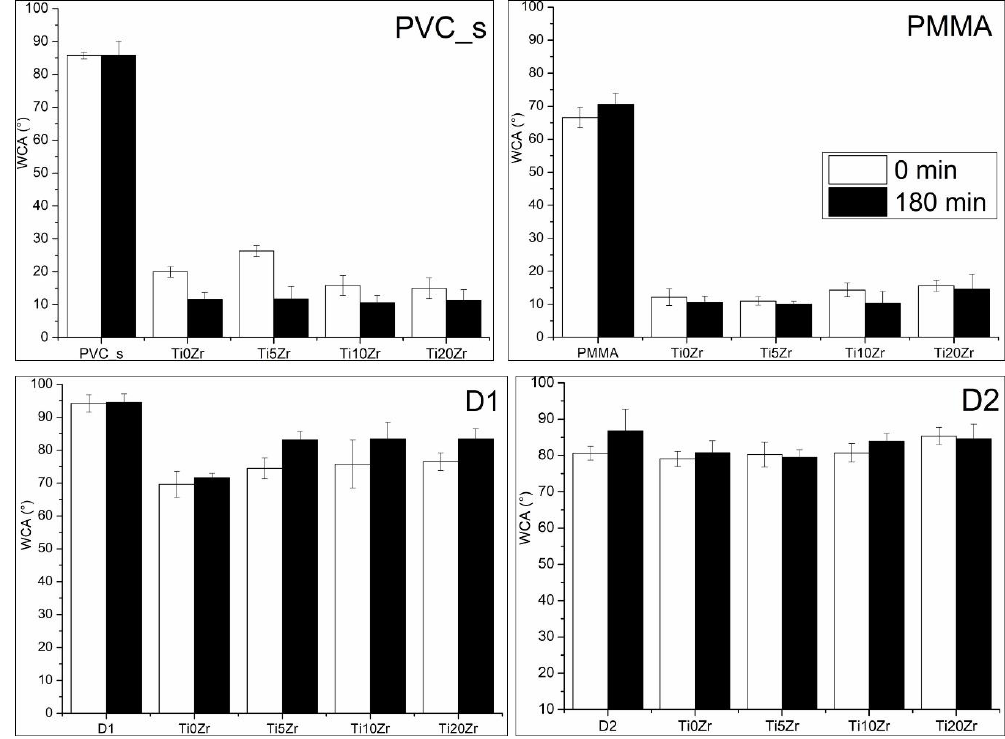
Figure 7. Water contact angle values for films with various Zr concentration deposited on different substrates, as marked by their first columns. Error bars represent standard error of the mean (N = 5).